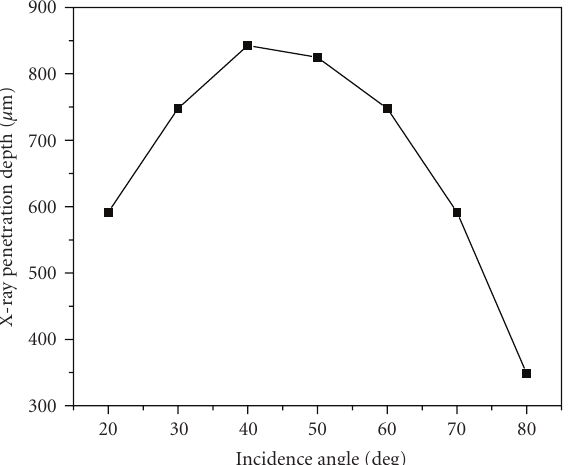
Figure 56: X-ray penetration depth in L-threonine crystals at various incident